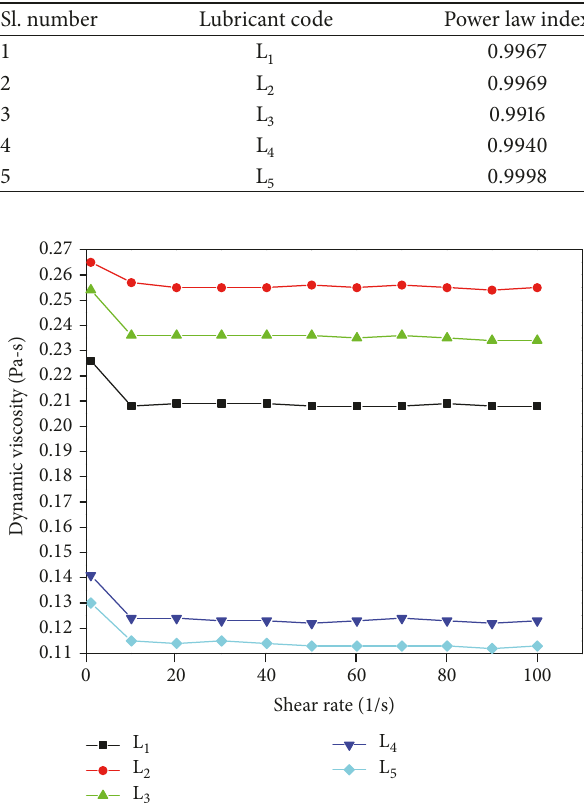
Figure 5: Variation of viscosity with shear rate for the lubricants.